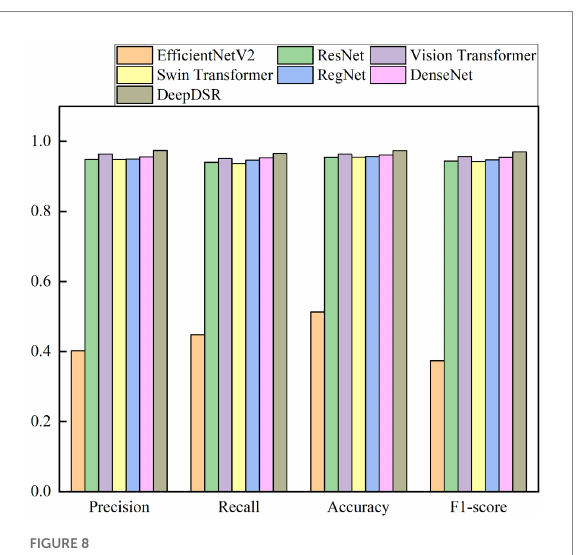
FIGURE 8 The performance of DeepDSR and other models for three- classification